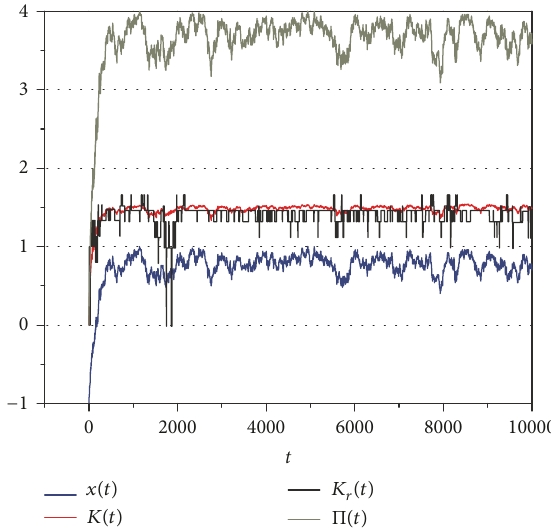
Figure 1: For the bottom-up SOCT: time evolution of the average social benefit Π(𝑡) , the average imitation strength 𝐾(𝑡) , the mean field 𝑥(𝑡) , and the imitation strength of one of the units 𝐾 𝑟 (𝑡) plotted versus time. The mean field fluctuates around 0.8 which means about 90 percent of individuals are cooperators and 10 percent are defectors. Mean field of 1 has all individuals in the state of cooperation, and the maximum average social benefit has the value 4, because this is the number of nearest neighbors on the two- dimensional